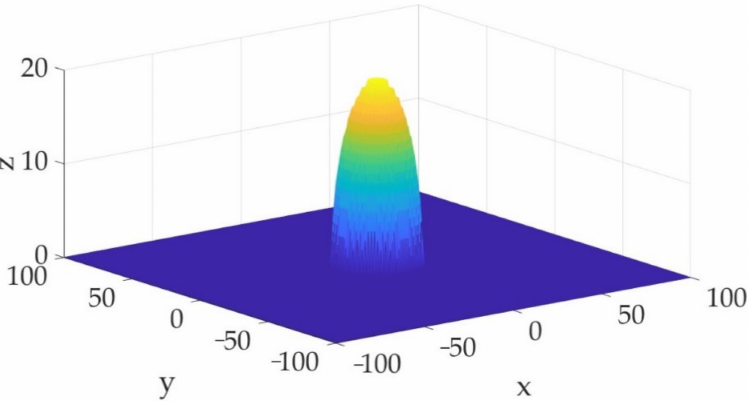
Figure 5. The iso-surface with a risk value of 10 − 3 at the moment of t0: